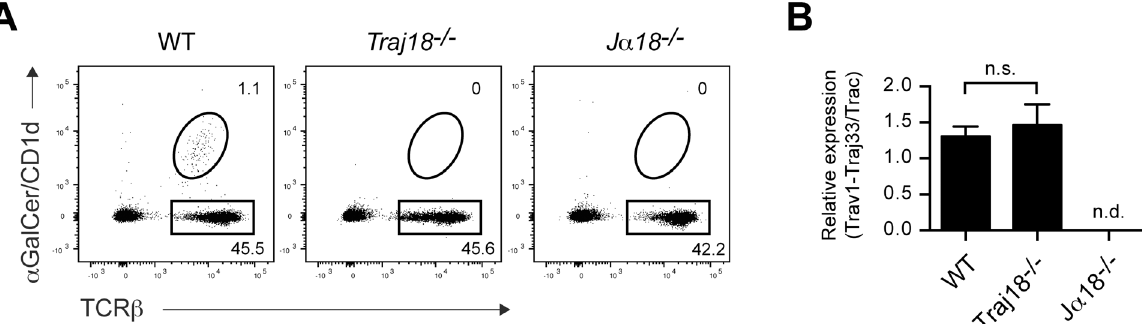
Fig 4. Normal development of MAIT cells with an invariant V α 19J α 33 in Traj18 -deficient mice. (A) Sorting strategy of α GC/CD1d - TCR β + lung T lymphocytes from WT, Traj18 -/- and previously generated J α 18 -/- mice. Numbers on FACS plots depict percentage of gated cells among viable 7-AAD - B220 - lung lymphocytes. (B) Relative expression of V α 19J α 33 mRNA by real-time quantitative RT-PCR in sorted lung cells shown in (A). Gene expression was normalized using Trac as internal control. Bars depict mean ± SEM, n.s., not significant using unpaired t test. All data are representative of three independent experiments with a combined total of three mice per